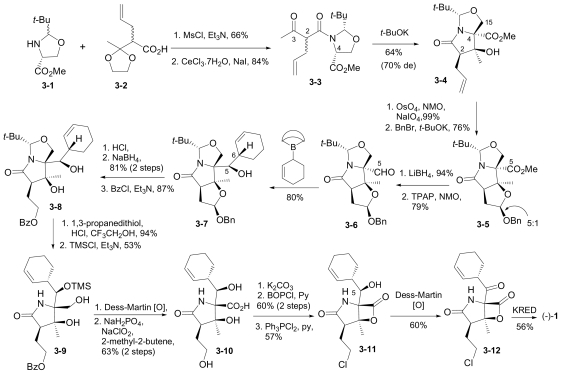
Nereus synthesis of (-)-1 from D-serine [41].